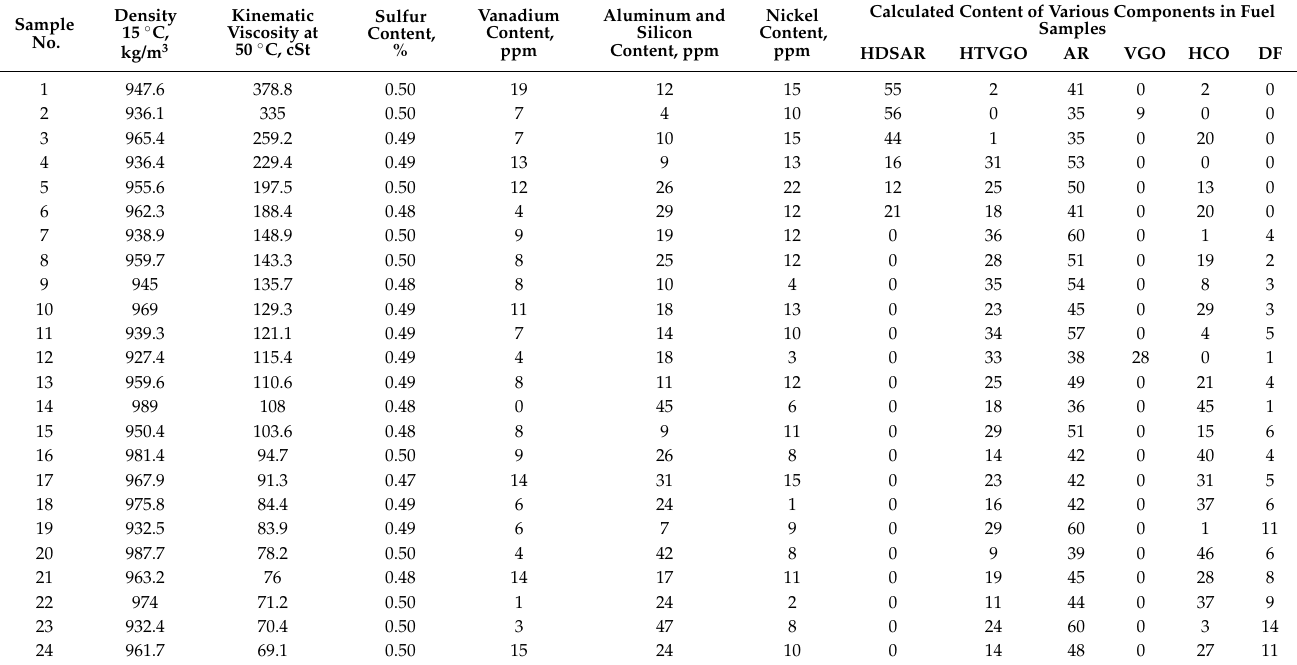
Table 13. Selected samples of VLSFO ports of Western Europe and the results of modeling their composition [90,91].